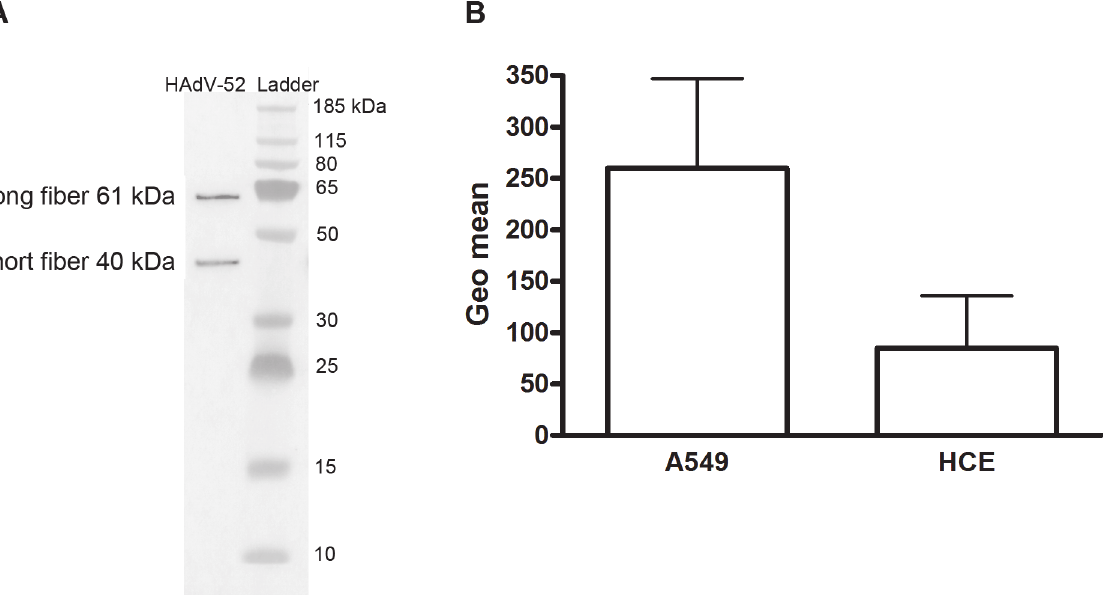
Fig 4. Virion composition and relative expression of CAR and sialic acid on human epithelial cells. A) Western blot analysis of HAdV-52 virion fiber content using a mouse mab (clone 4D2) recognizing an epitope (MKRARPSEDTFNPVYPY) conserved in the tail domain of all HAdVs. The experiment was performed three times (with three different virus preparations) and the figure shows one representative set of results. B) Flow cytometry analysis of CAR expression on A549 and human corneal epithelial (HCE) cells using an anti CAR mouse mab (clone E1-1). Data are shown as geometrical mean (geo mean) and the experiment was performed three times with duplicate samples in each experiment. Error bars represent means ±